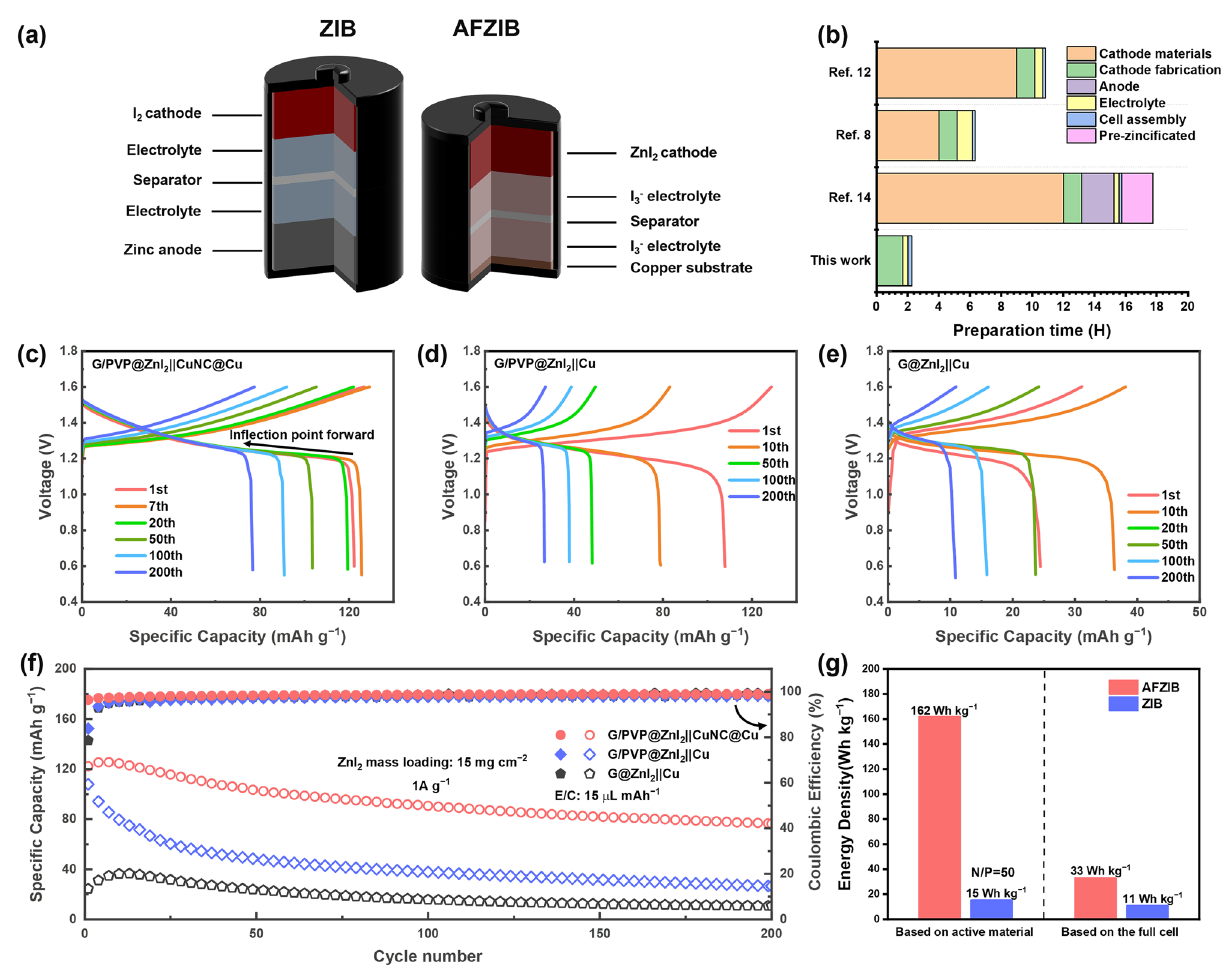
Fig. 6 a Schematic illustrations of the cell configurations of ZIB and AFZIB. b Comparison of preparation time of AFZIB and recently reported AFZBs. c–e GDC curves at 1 A g −1 of AFZIB with different battery configurations: c G/PVP@ZnI 2 cathode || CuNC@Cu anode, d G/PVP@ ZnI 2 cathode || Cu anode, e G@ZnI 2 cathode || Cu anode. f Cycling stability of AFZIB at 1 A g −1 with different battery configurations. g Com- parison of gravimetrical energy density of AFZIB and ZIB based on the mass of active material or the mass of full